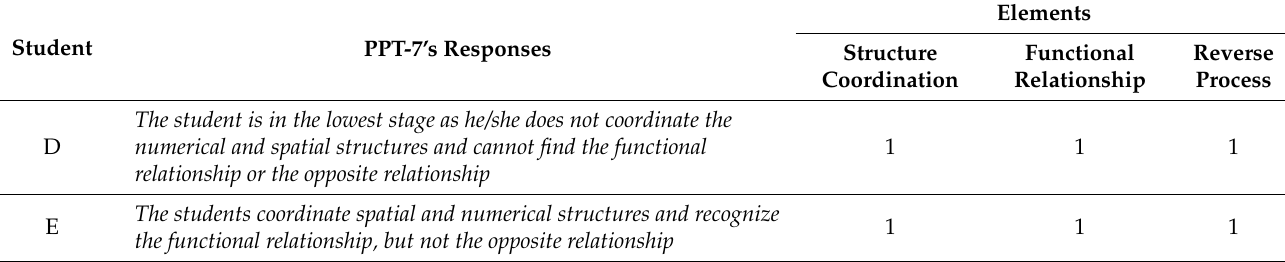
Table 9. PPT-7’s responses from Profile